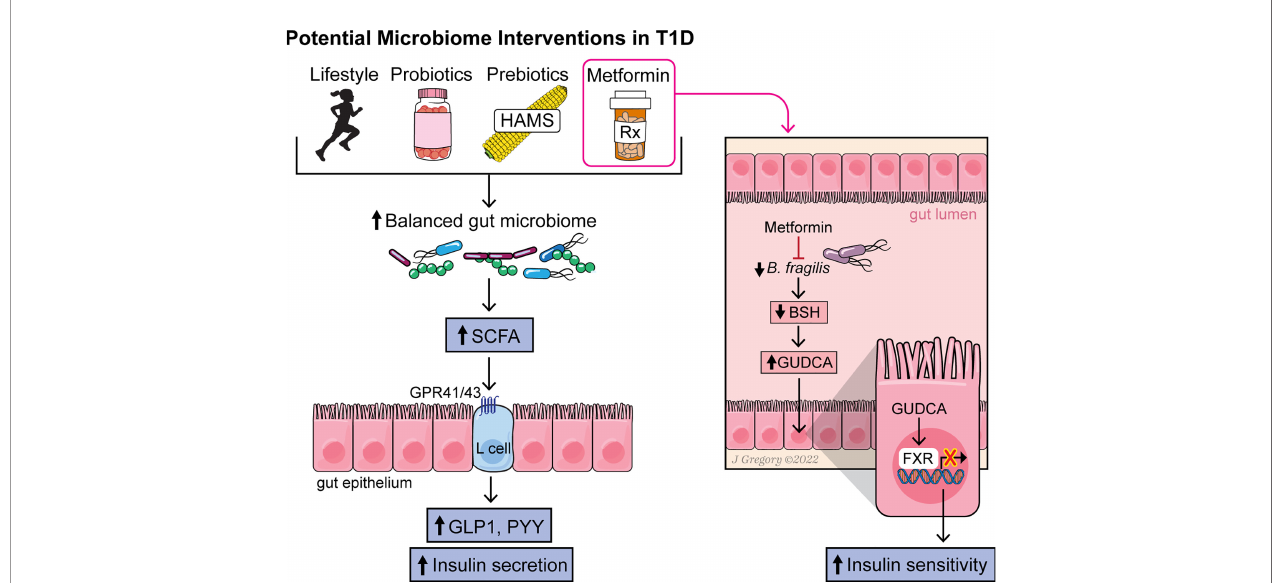
FIGURE 1 | Figure summarizing the effect of various interventions on the gut microbiome, microbial metabolites and pathways leading to increased insulin sensitivity and secretion.